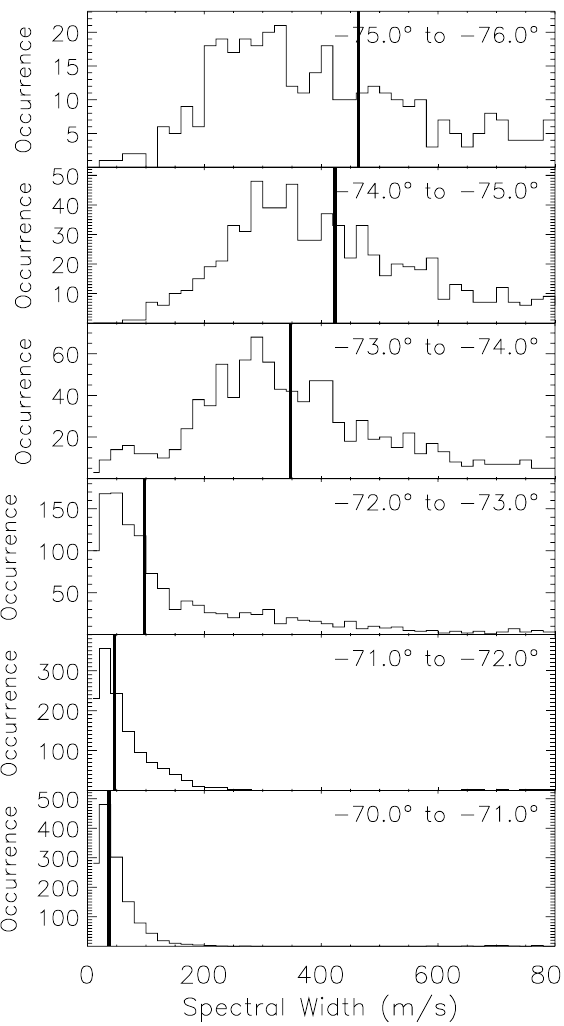
Fig. 3. The distributions of spectral width from all beams of the Halley radar measured during the interval 12:40–13:40 UT (interval A) on 14 August 1998. The distributions have been split into 1 ◦ latitude bins from − 70 ◦ to − 76 ◦ . The bold vertical lines represent the medians of each